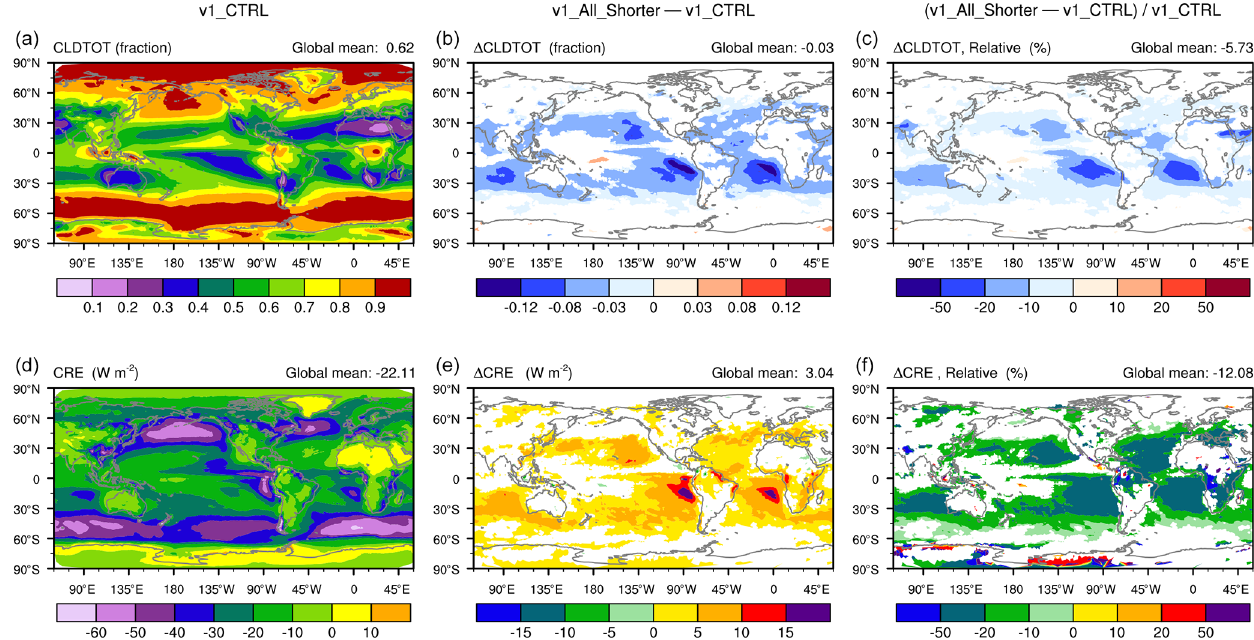
Figure 5. (a, d) The 10-year mean geographical distribution of total cloud cover (CLDTOT, a, b, c ) and total cloud radiative effect (CRE, lower row) in v1_CTRL. (b, e) Differences between v1_All_Shorter and v1_CTRL. (c, f) Relative differences with respect to v1_CTRL. Statistically insignificant differences are masked out in white. The simulation setups are described in Sect. 2.3 and also summarized in group I in Tables 1 and A1. Schematics depicting the time integration loop and different step sizes can be found in Fig. 2.